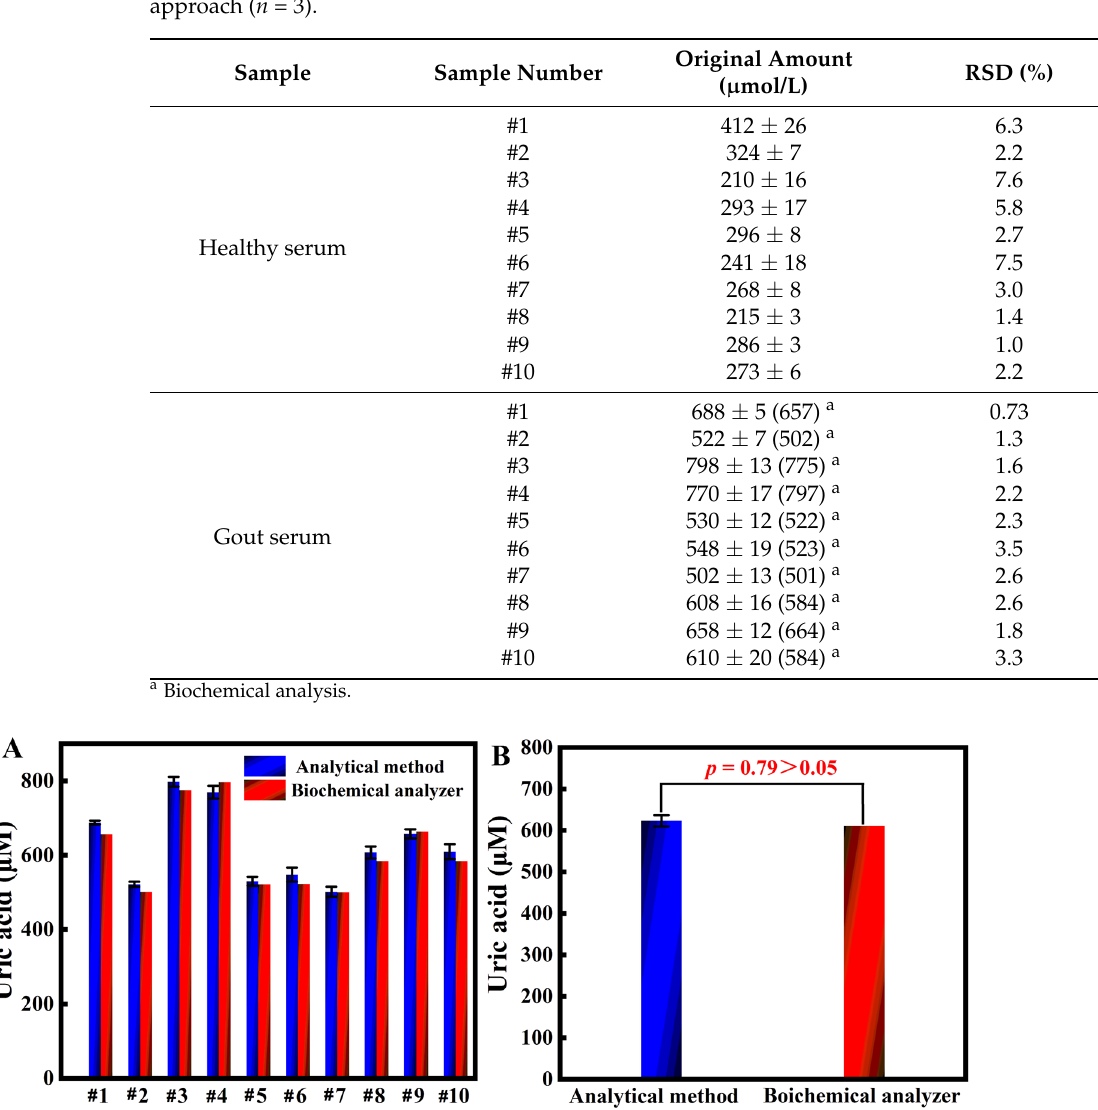
Table 2. Results for the detection of UA using our system and using the hospital biochemical analysis approach ( n = 3).